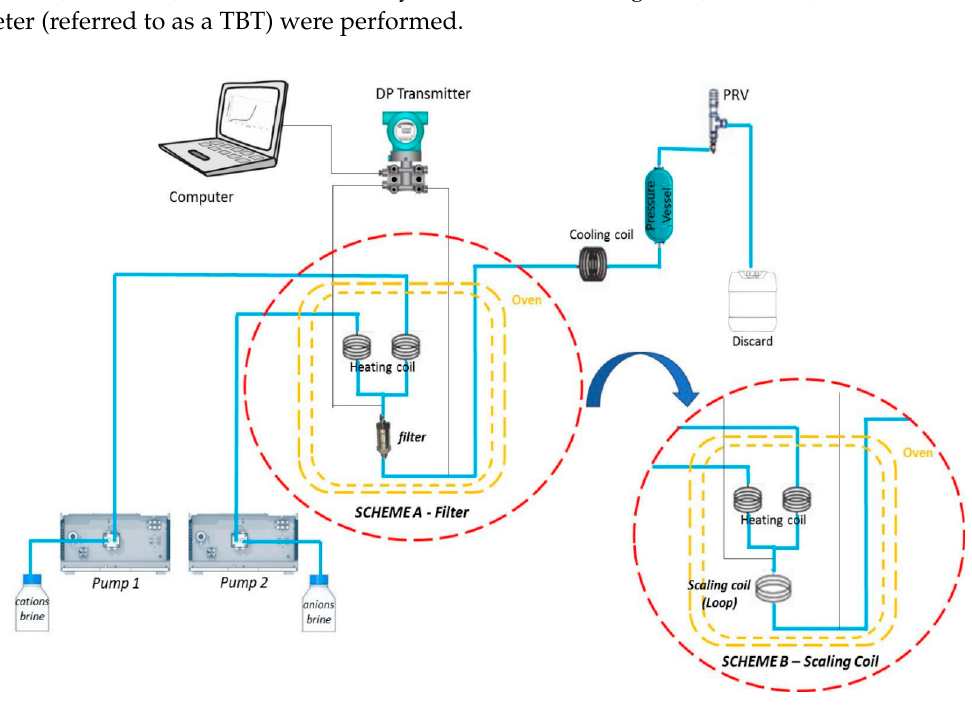
Figure 2. Schematic of dynamic scale system: Scheme A—using a filter with 7 µ m pores and Scheme B—using a scaling coil with 500 µ m inner